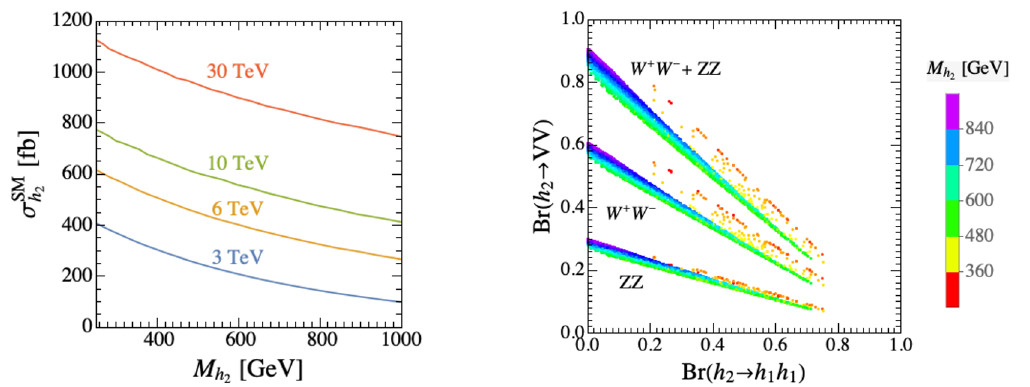
Figure 2 . Left: the SM-like production cross section of h 2 at muon colliders with different collision energies. Right: the scattering plots for the Br ( h 2 → V V ) and Br ( h 2 → h 1 h 1 ) corresponding to the FOEWPT data points, and the value of M h is shown in 2